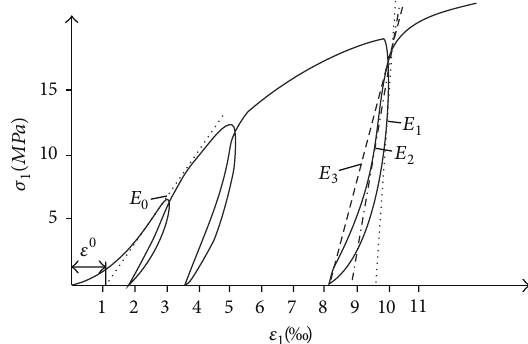
Figure 6: Triaxial creep of rock salt samples at different temper- atures ( 𝑇 ) and stress conditions ( 𝜎 1 − 𝜎 2 ) from the Polkowice- Sieroszowice copper ore mine